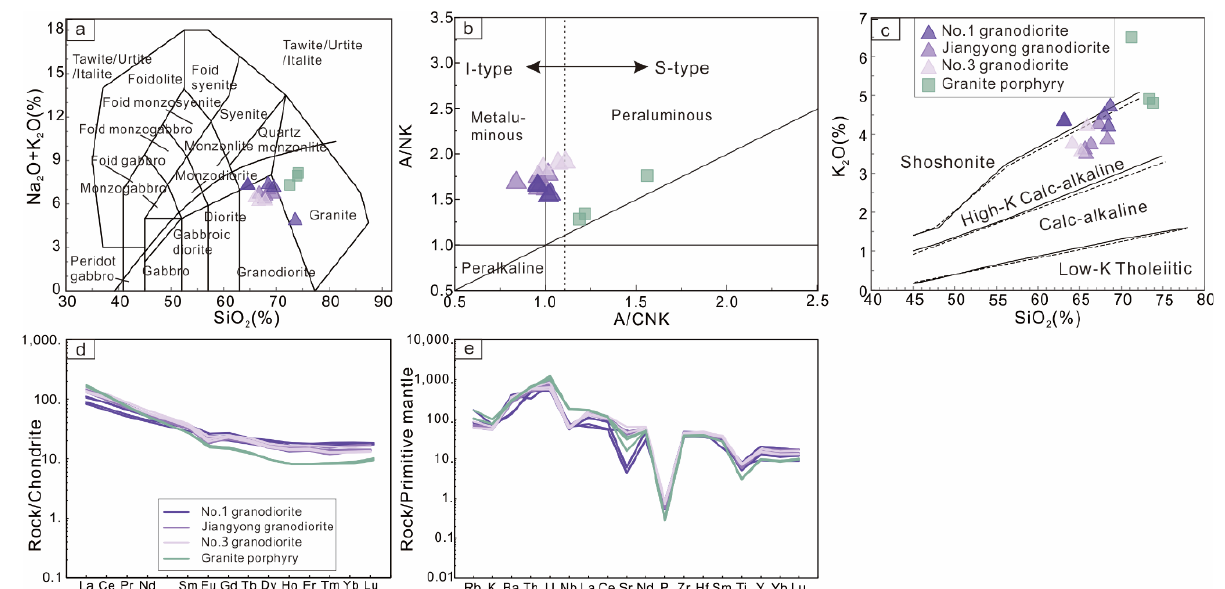
Figure 5. Geochemical classification diagrams for the Tongshanling granitoids: ( a ) TAS diagram (after [52]); ( b ) A/CNK vs. A/NK plot (where A = Al 2 O 3 , C = CaO, N = Na 2 O, and K = K 2 O in molar values, after [53]); ( c ) SiO 2 vs. K 2 O plot (after [54]). Normalized trace-element patterns: ( d ) chondrite-normalized rare earth element patterns; ( e ) primitive-normalized trace-element patterns (normalization after [55]).